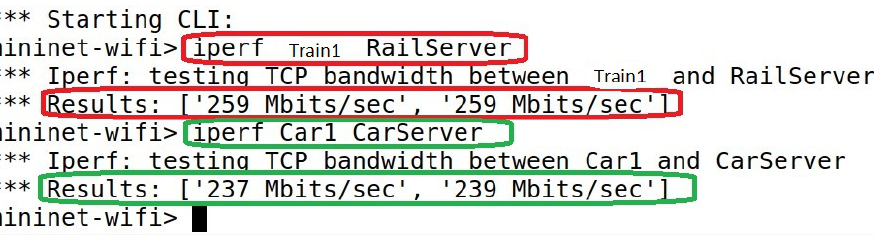
Figure 26. Link capacity